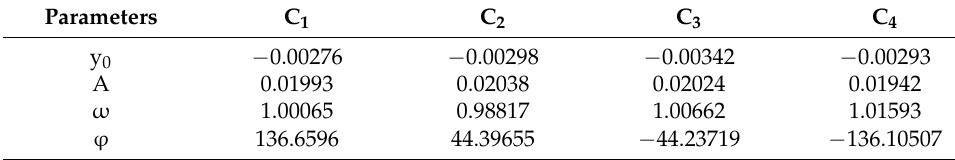
Figure 10. Measured capacitance normalized by the initial value when the wind speed was fixed at 12.7 m/s and the wind direction was changed from 0° to 360°. Table 3. Fitting results of the measured capacitance change magnitude.